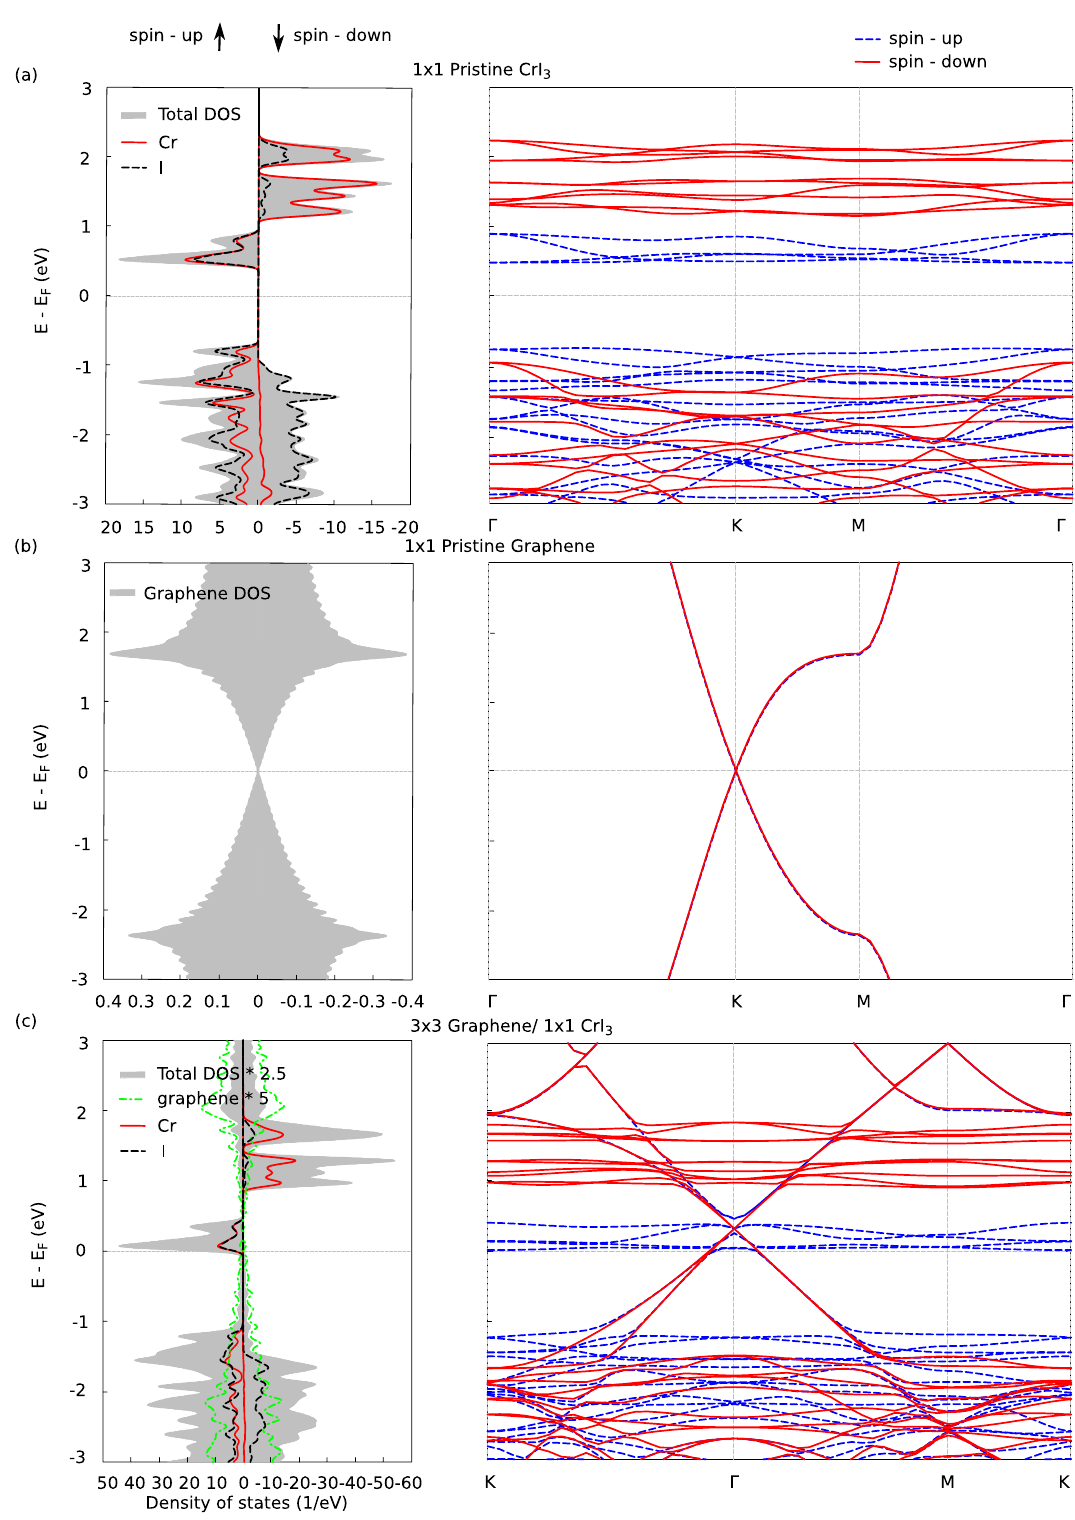
Figure 4. Spin-polarized projected density of states (DOS) and bandstructure for ( a ) pristine monolayer CrI 3 with 1 × 1 unit cell ( b ) pristine monolayer graphene with 1 × 1 unit cell ( c ) 3:1 G/CrI 3 (top configuration) with 3 × 3 graphene adsorbed on 1 × 1 CrI 3 . Total DOS (grey) is magnified 2.5 times and DOS of C(dashed green) is magnified 5 times and Gaussian smearing of 0.004 eV has been used to visualize the